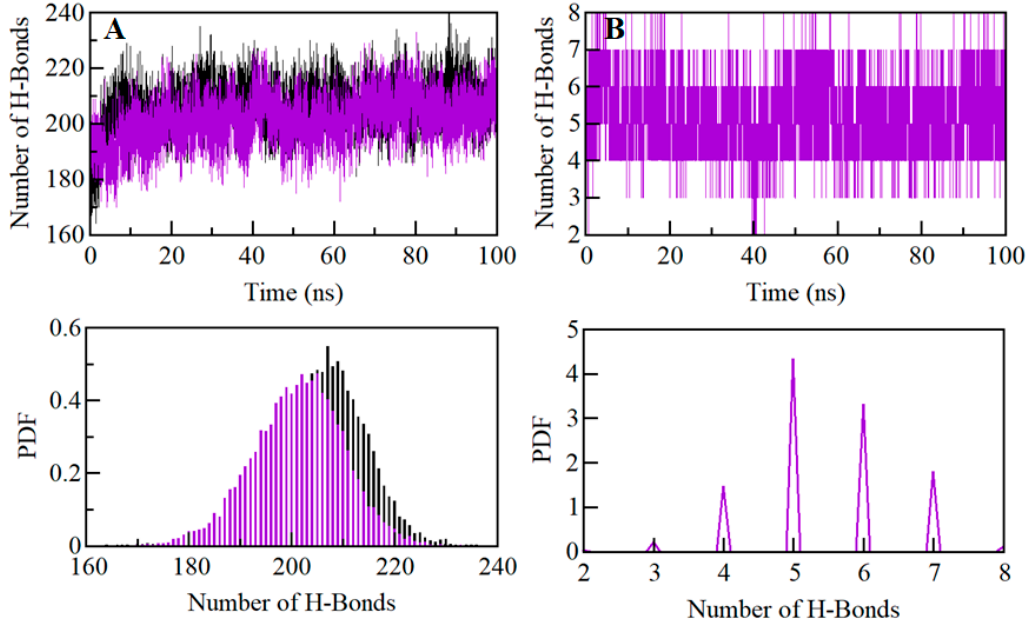
Figure 6. Time evolution and stability of hydrogen bonds formed ( A ) Intramolecular within SGK1, and ( B ) Intermolecular between compound ZINC00319000 and SGK1 (lower panel shows the probability of distribution of hydrogen bonding as PDF).